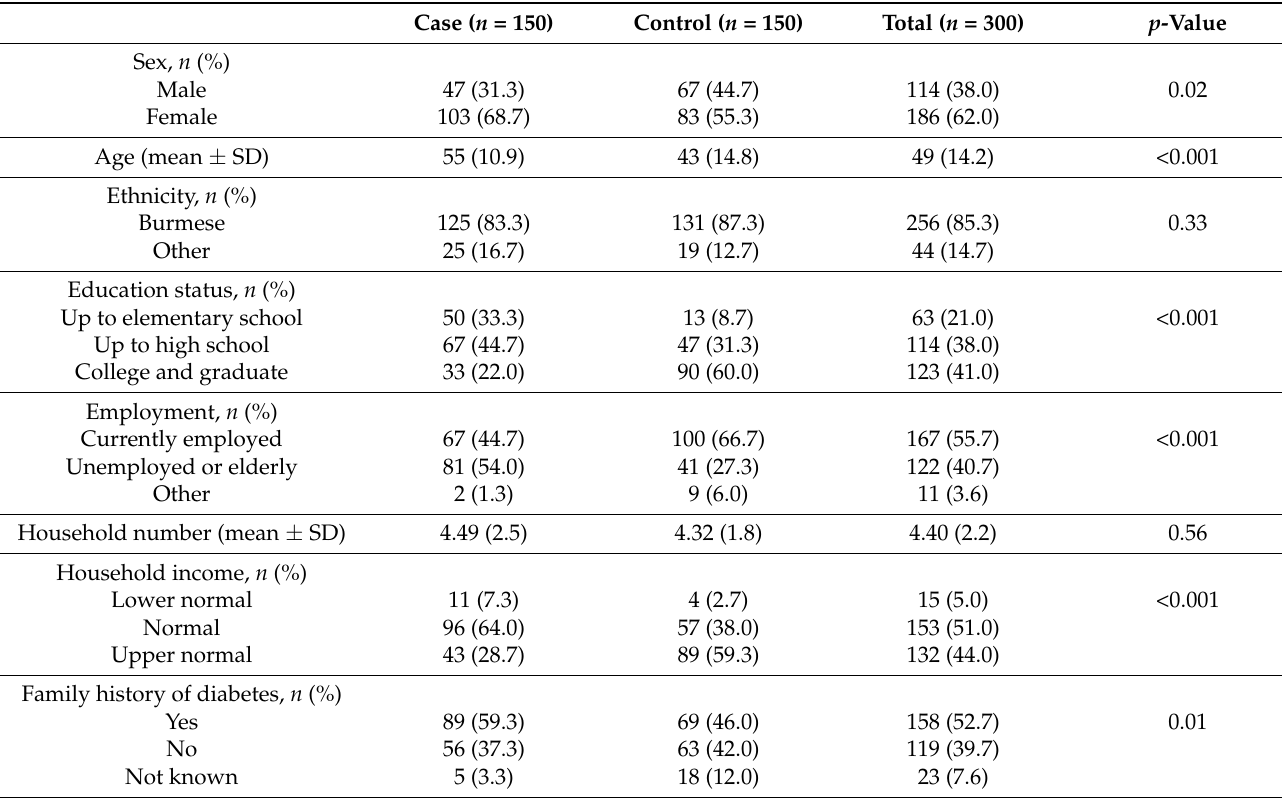
Table 1. Basic characteristics of the participants.